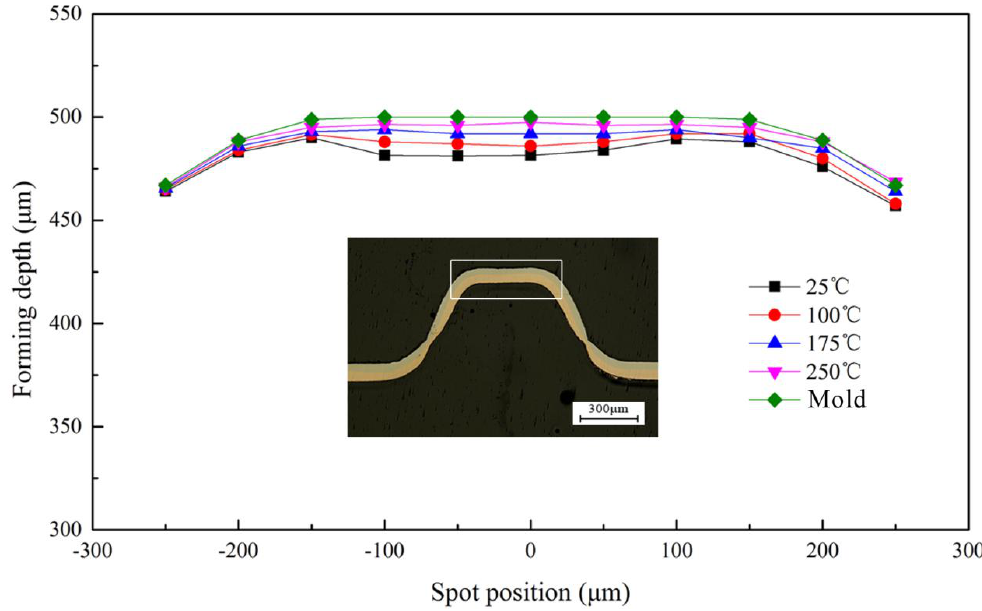
Figure 18. The effects of temperature on the fitability at 1800 mJ.